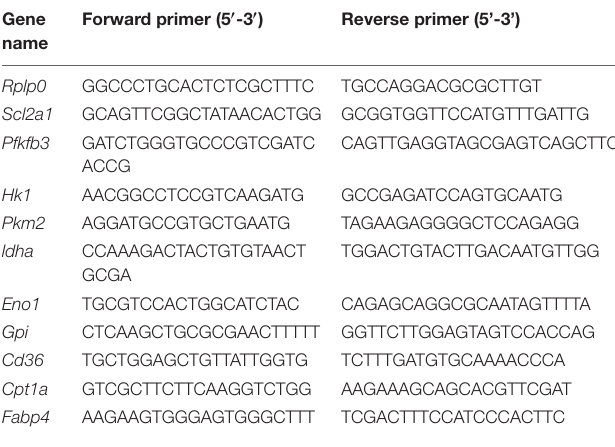
TABLE 2 | Sequences of primers used in real-time PCR